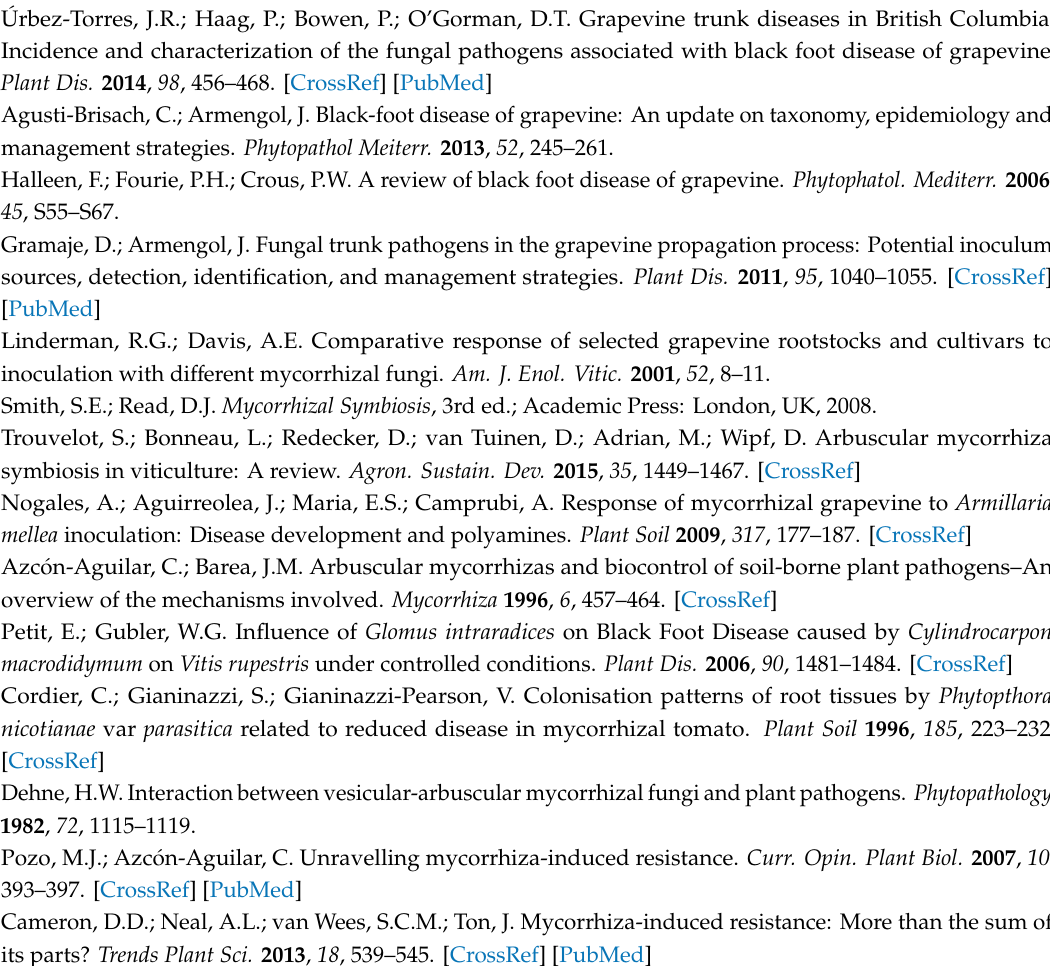
Figure S1: Specificity test using the newly designed primer probe in a digital droplet PCR assay. Droplets above the threshold represent positive amplification to the primer / probe. From left to right the isolates tested in each well are: A01– PARC393 , A02–PARC349, B02-PARC100, C01- PARC60 , C02–NTC, D01– PARC340 , D02– Rhizophagus irregularis (DAOM197198), E01– PARC72 , G01–PARC398, H01–PARC345. Rhizophagus irregularis DNA originated from spores that were extracted from the AGTIV ® product. Table S1: A lineage report resulting from specificity testing for the new primer-probe set, using the blast tool in NCBI. First a primer blast was performed using the newly developed primer set. The generated accession numbers were subsequently nucleotide blasted using the probe sequence. The organism, score, average e-value and number of hits for each match are